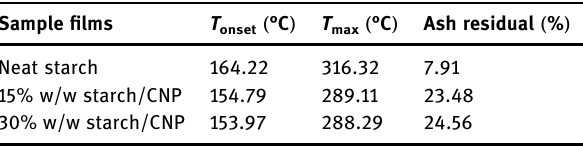
Table 2: TGA parameter values for neat starch and starch/CNP fi lms at the second stage of thermal decomposition Sample fi